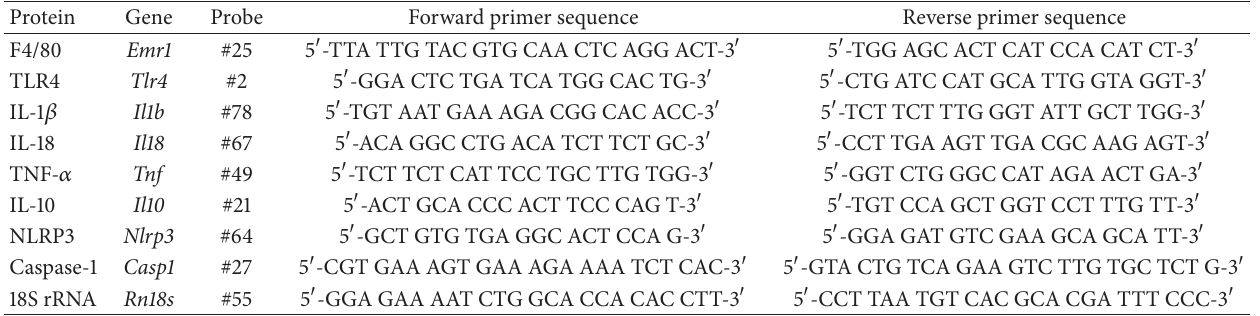
Table 1: Primers and probes used in the real-time